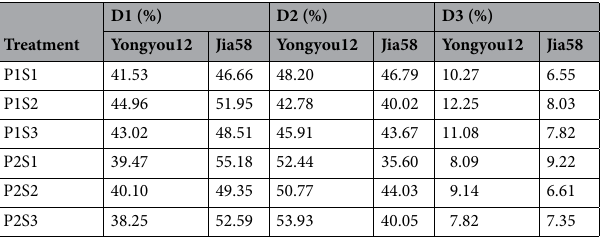
Table 2. Rice canopy different size distribution of droplets. The average diameter of all droplets is D, grouped by 0–80%D, 80–160%D, > 160%D (numbers are D1, D2, D3).